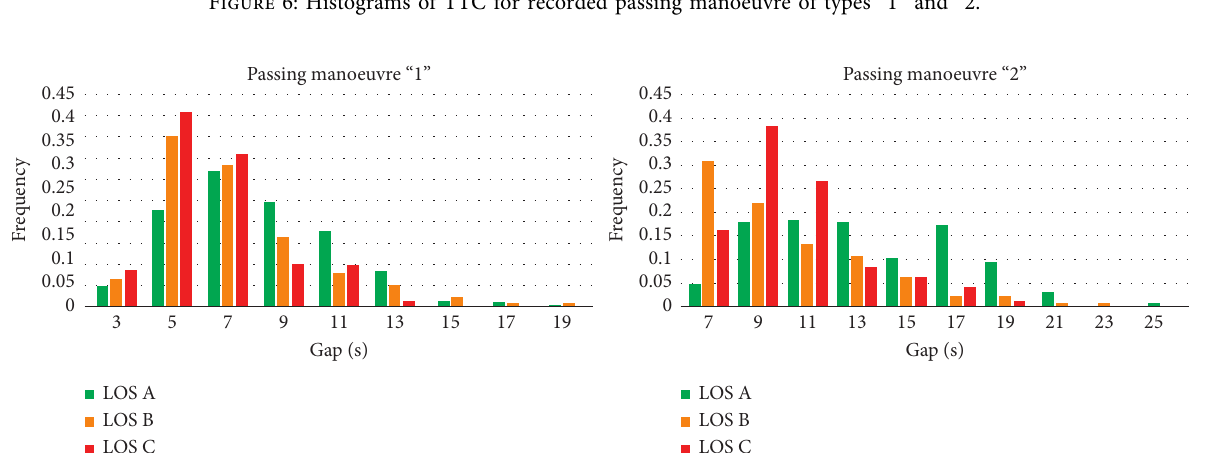
Figure 6: Histograms of TTC for recorded passing manoeuvre of types “1” and “2.”